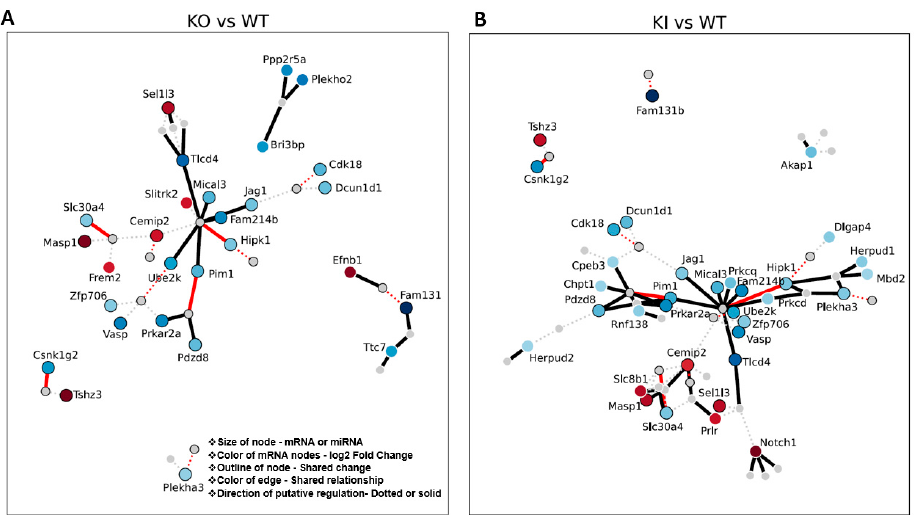
Figure 7. Putative mRNA–miRNA target regulation (from miRNA and mRNA DEGs) in the RS of KO, KI, and WT groups. mRNA–miRNA pairs in ( A ) KO vs. WT or ( B ) KI vs. WT group showing interaction (network). mRNA–miRNA pairs (only miRNA and mRNA changed in RS) in the genotype of interest showing interaction (positive or negative) identified jointly across databases. Red circles = upregulated compared to WT. Blue circles = downregulated compared to WT. Darker color circles = higher magnitude change. Each line represents a connection of a miRNA to an mRNA if it was identified jointly across databases. Thicker line = canonical change “miRNA down and mRNA up or miRNA up and mRNA down”. Dotted line = non-canonical “miRNA down and mRNA down or miRNA up and mRNA down”. Bright red line (dotted or not) = KO and KI behave similarly. Black outline around a node (circle) = node was shared in both KO and KI DEGs. A white outline around a node means that the node was unique to that genotype.